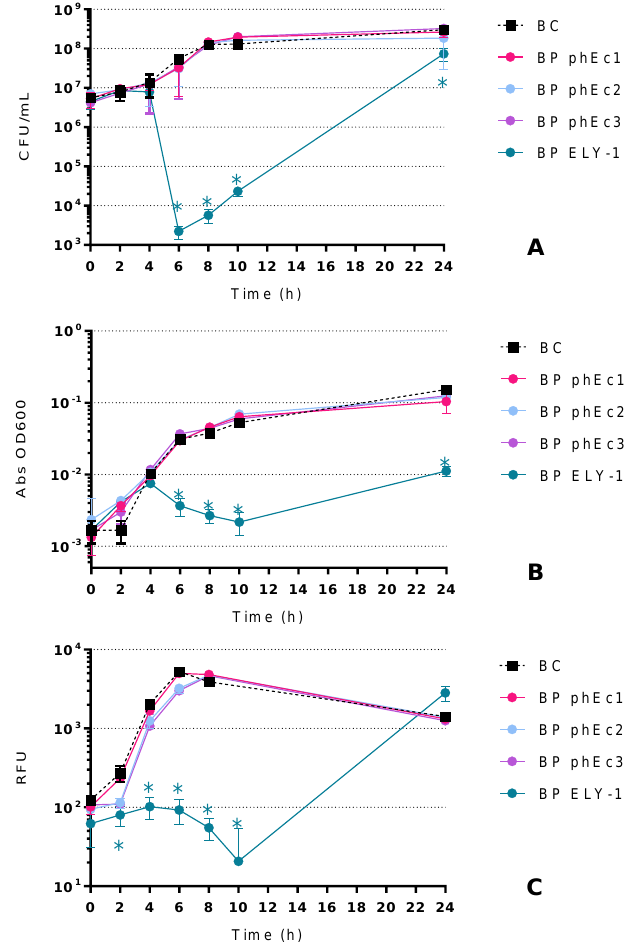
Figure 2. Inactivation of E. coli by four E. coli phages (phEc1, phEc2, phEc3 and ELY-1) at a multiplicity of infection (MOI) of 10 for 24 h. Bacterial concentration of E. coli through colony-counting ( A ), optical density ( B ) and cell viability ( C ) methods: BC-Bacteria Control; BP-Bacteria plus Phage. Values represent the mean of three independent assays; error bars represent the standard deviation. * p < 0.05 (relative to the respective control).